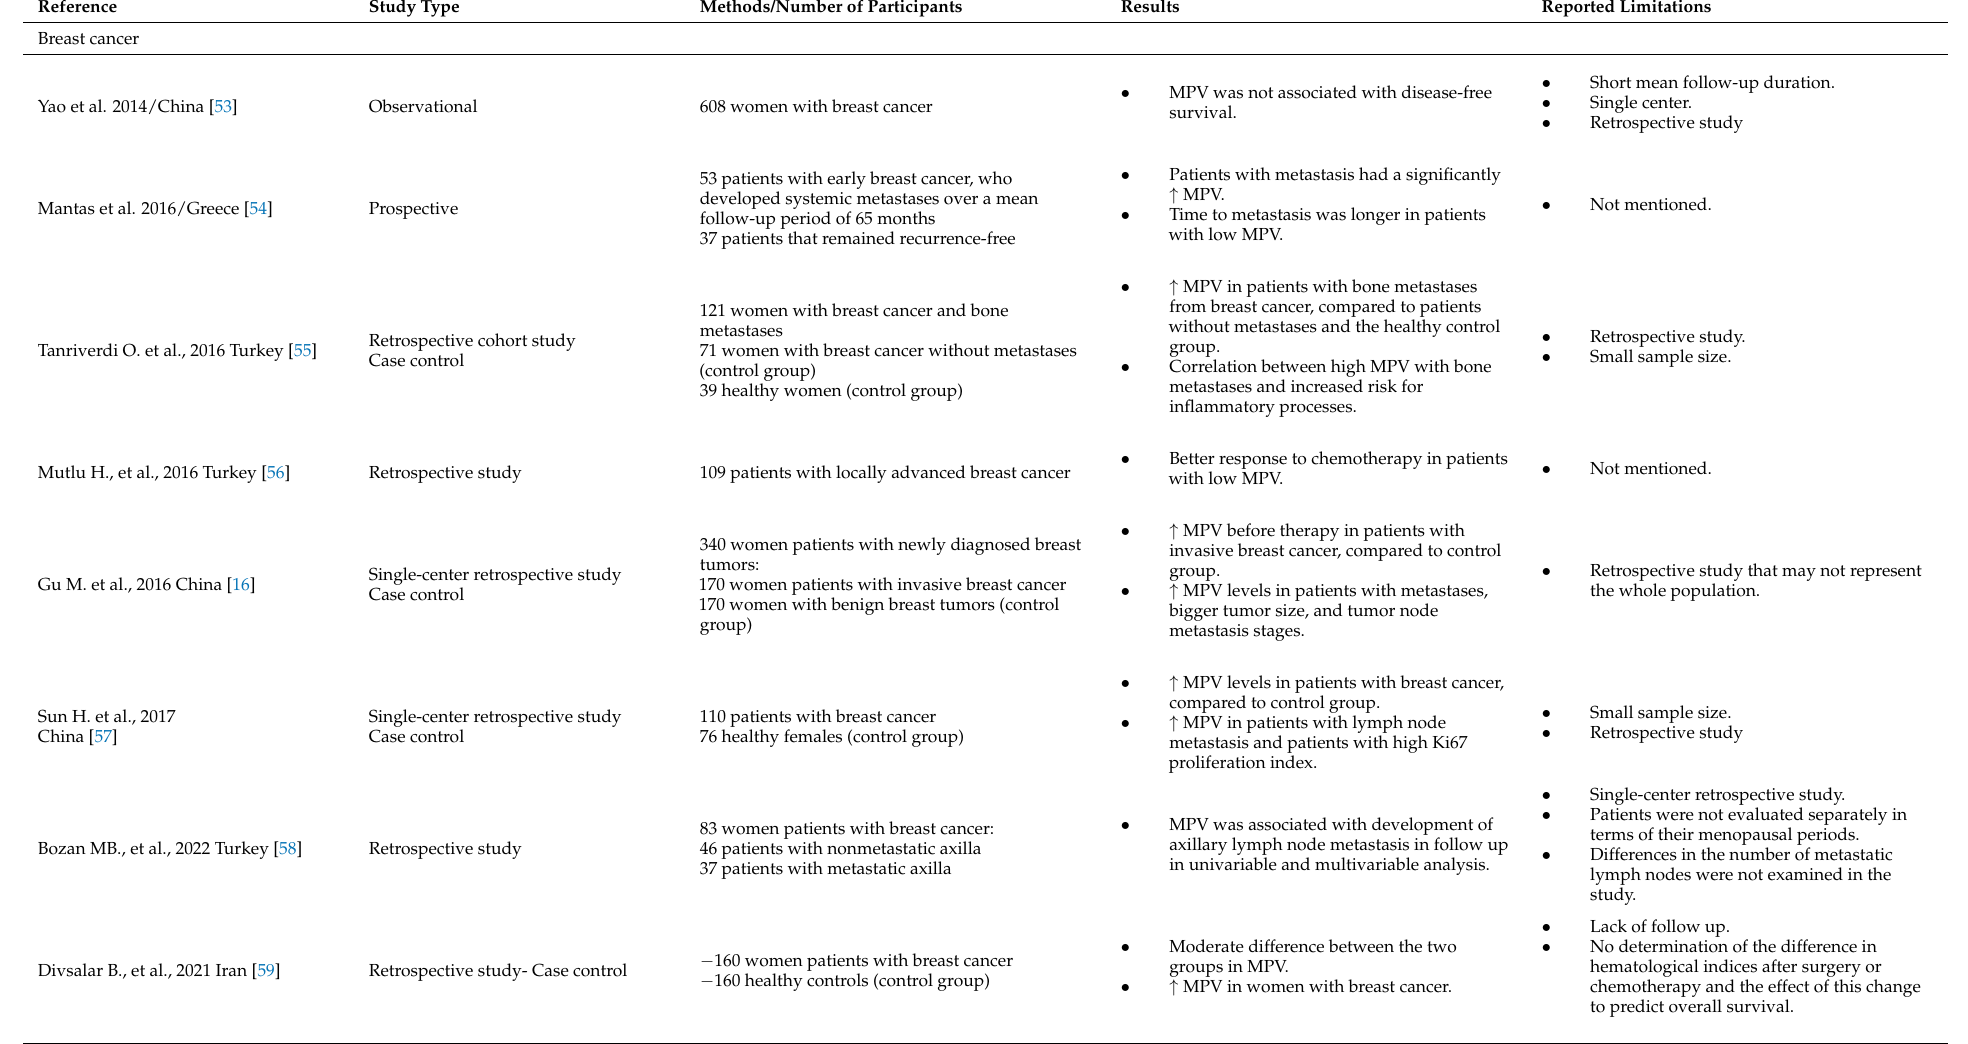
Table 4. Studies relating MPV to breast, ovarian, and endometrial